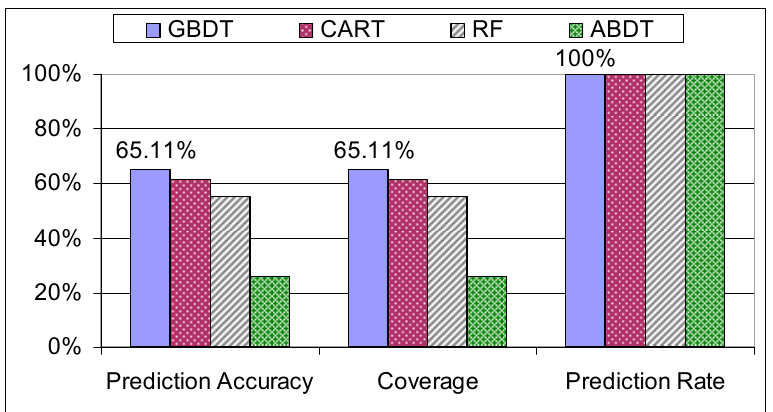
Figure 13. Evaluation of decision trees on the mixed dataset.